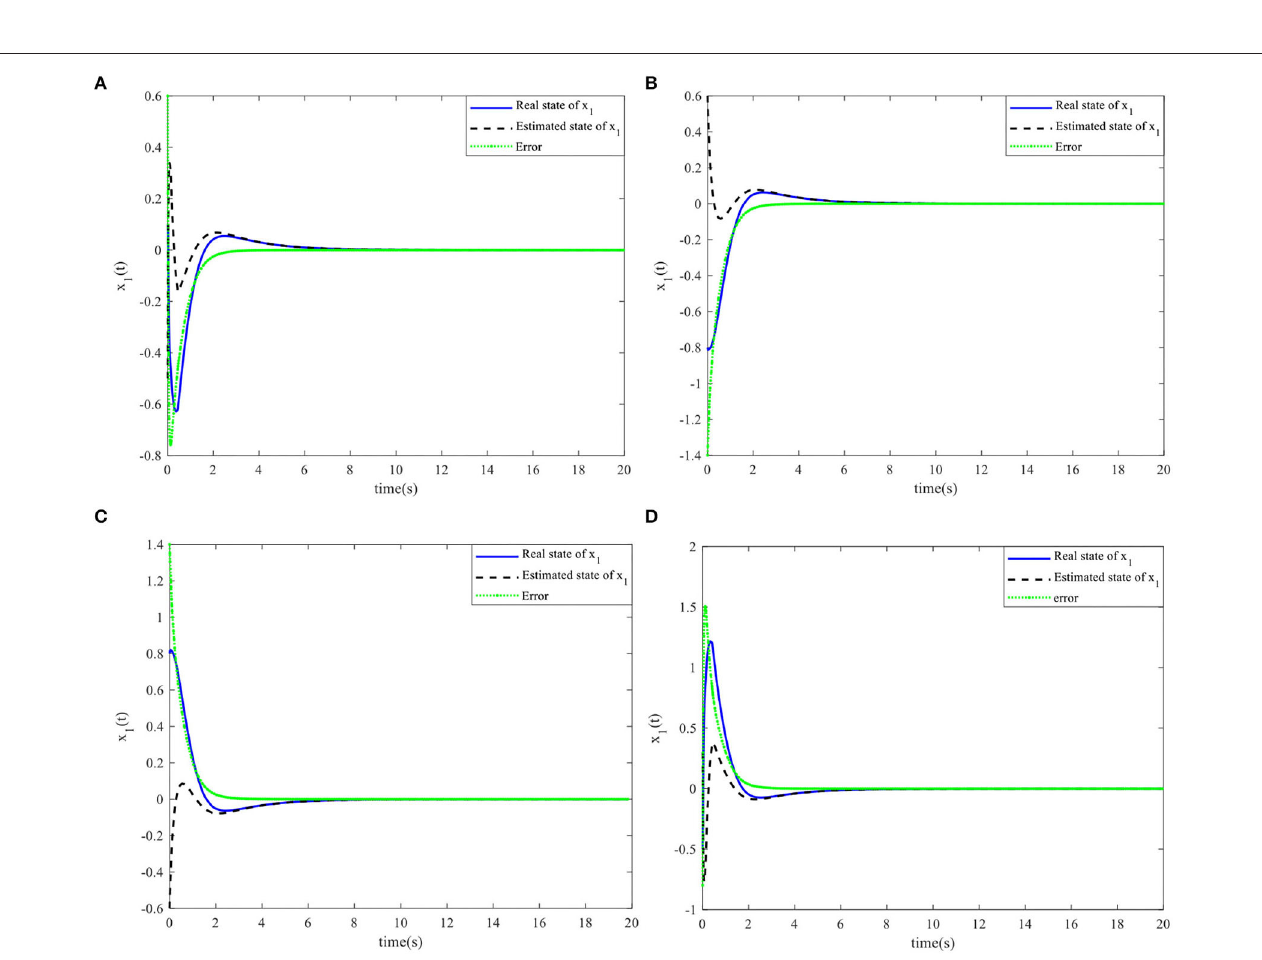
FIGURE 5 | Nonlinear state x 1 ( t ) and the estimated ˆ x 1 ( t ). (A) Initial simulation case 1. (B) Initial simulation case 2. (C) Initial simulation case 3. (D) Initial simulation case 4.